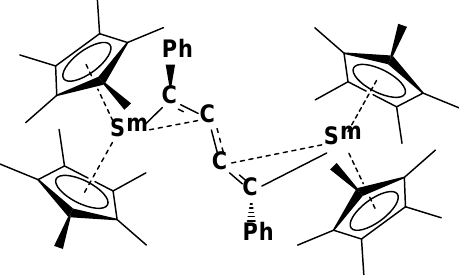
Figure 3. Dimeric complex [(Cp* 2 Sm) 2 (µ- η 2 : η 2 –PhC 4 –Ph)] obtained from the reaction between solvent-free samarocene and phenylacetylene [18].